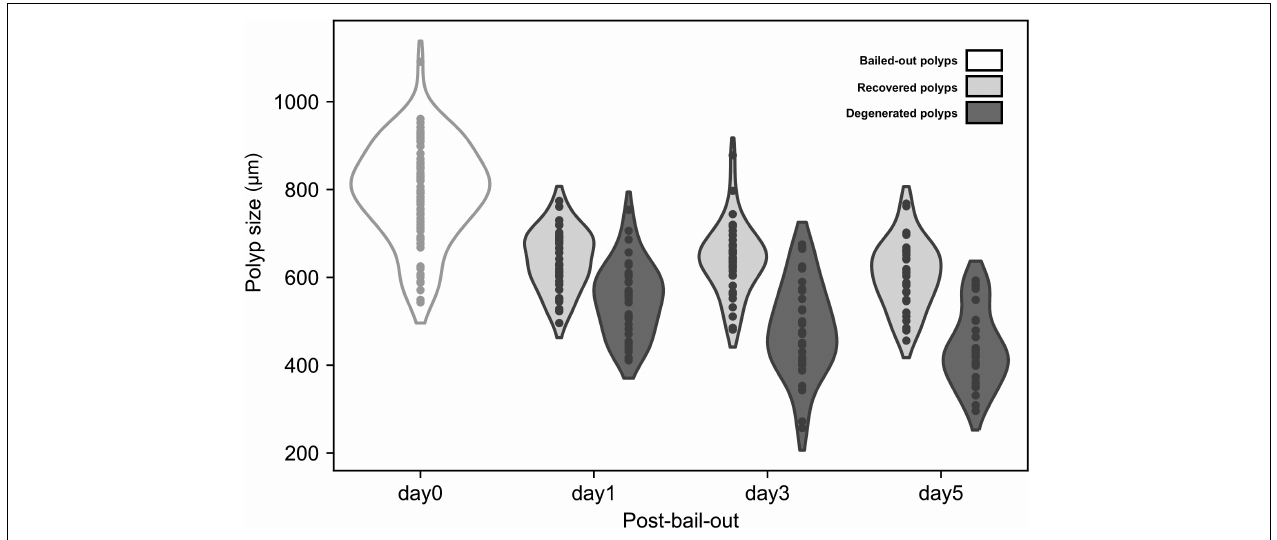
FIGURE 3 | Size reduction of bailed-out polyps. Bailed-out polyps of different morphotypes (recovered or degenerated) are displayed for day1, day3, and day5 post-bail-out.